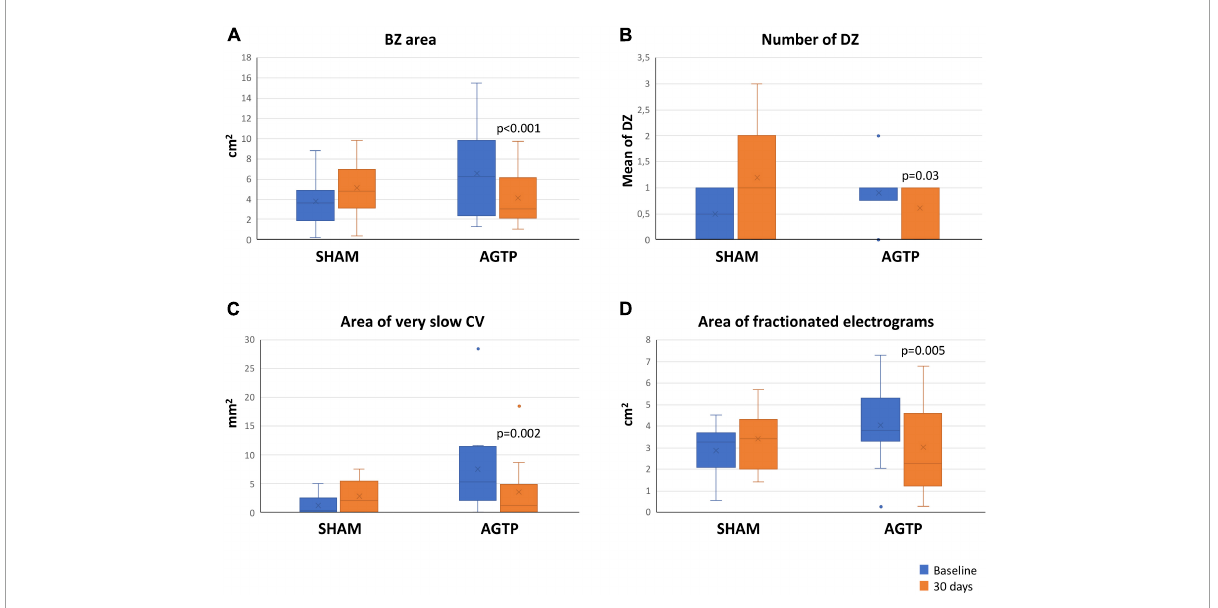
FIGURE3 Baseline and follow-up mapping data. Boxplots shows significant differences in the area of border zone tissue (A) , number of deceleration zones (B) , very-slow conduction velocity (C) , and highly fractionated electrogram area (D) . BZ, border zone; CV, conduction velocity; DZ, deceleration